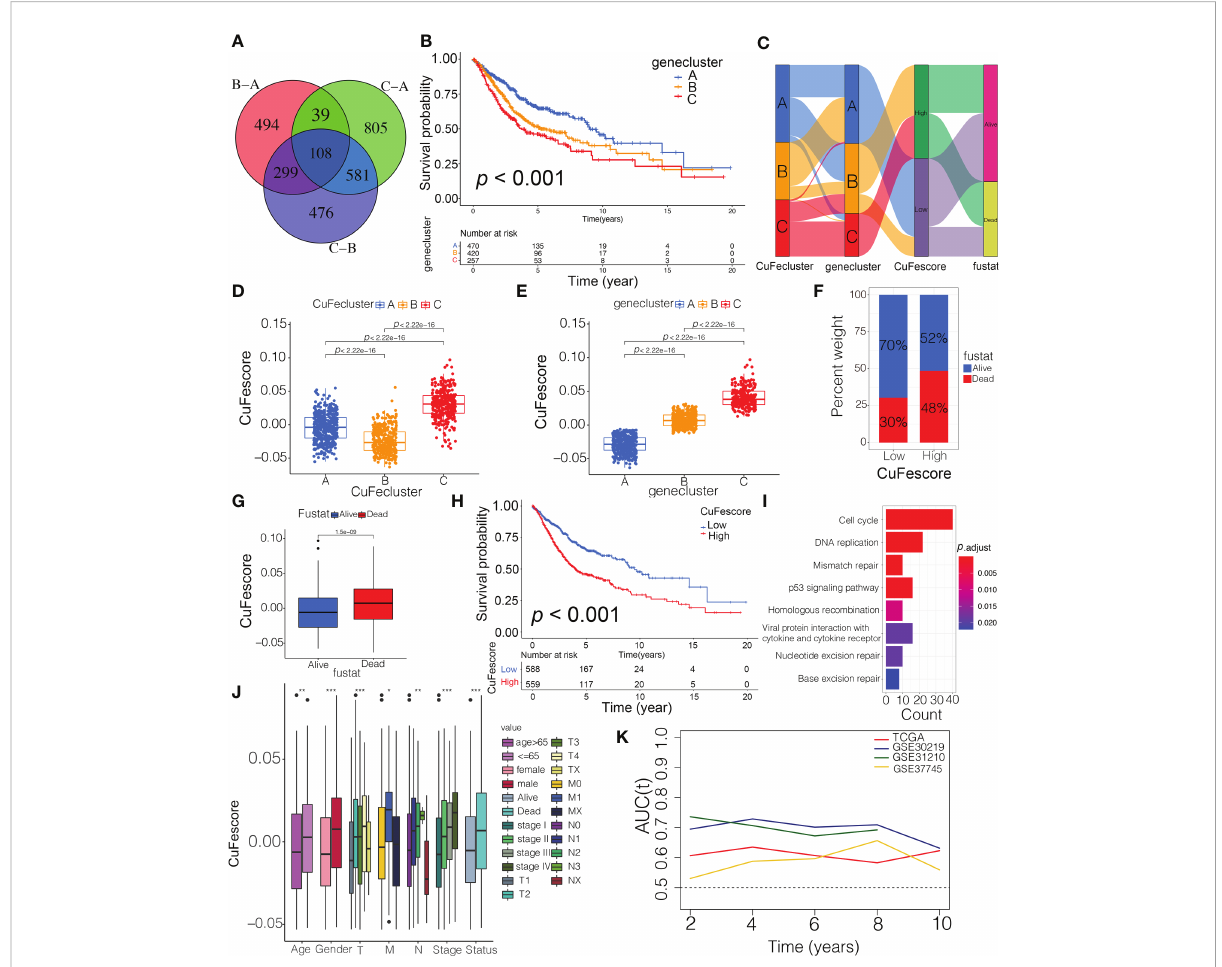
FIGURE 5 Construction of the CuFescore and the prognostic values of the CuFescore. (A) Overlapped cuproptosis/ferroptosis-related genes shown in Venn diagram. (B) Kaplan-Meier curves of survival in 6 cohorts with three distinct geneclusters. (C) Alluvial diagram showing the changes in CuFeclusters, geneclusters and CuFescores. CuFescore in distinct (D) CuFeclusters and (E) geneclusters. (F) Proportion of survival and death in the high and low CuFescore groups. (G) Comparison of the CuFescore in alive versus dead patients. (H) Kaplan-Meier curves of survival in the high and low CuFescore groups. (I) Functional annotation for DEGs between the low and high low CuFescore groups using GO enrichment analysis. The color depth of the barplots represented the number of genes enriched. (J) Difference in CuFescore among distinct clinical subgroups in LUAD cohort. (K) Time-dependent AUC value in TCGA-LUAD, GSE30219, GSE31210 and GSE37745. AUC, area under curve. * p < 0.05, ** p < 0.01, *** p <